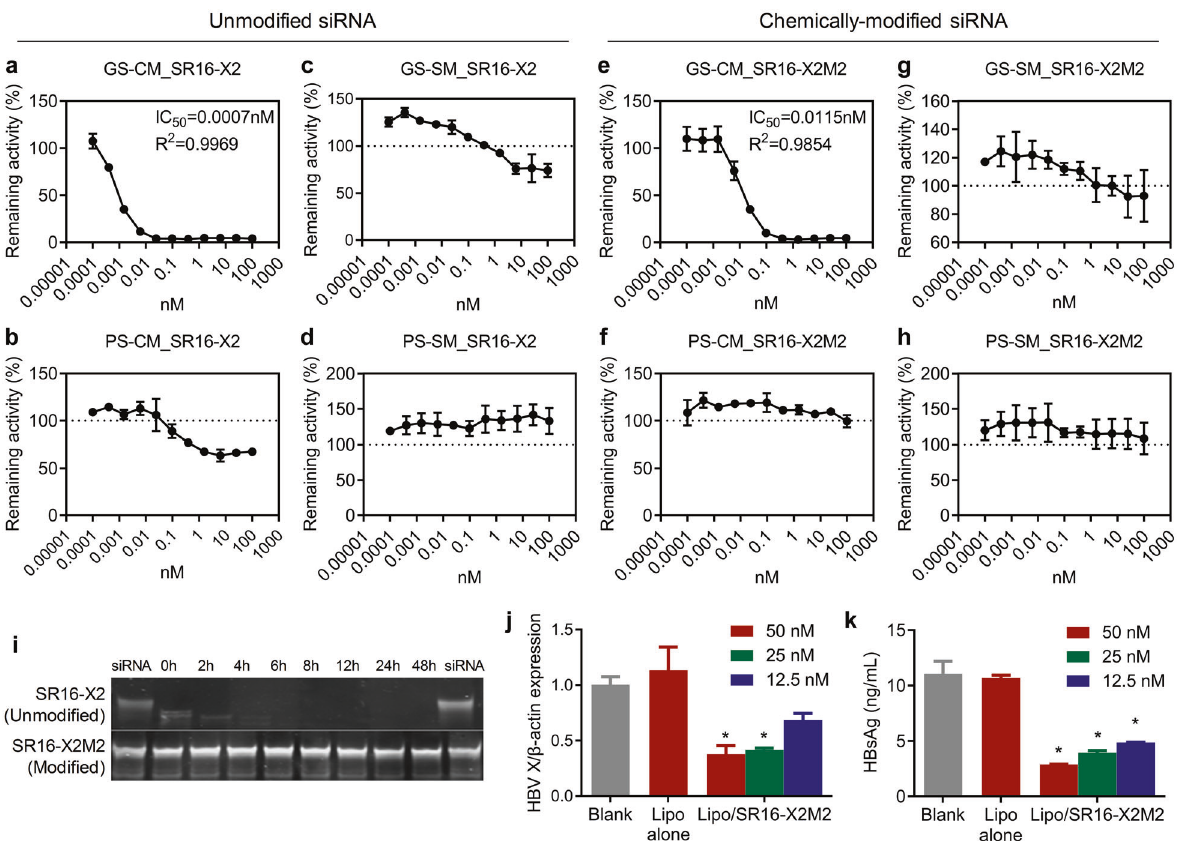
Fig. 3 In vitro performances of anti-HBV siRNAs. a – h On target and off-target activities of the unmodi fi ed ( a – d ) and chemically modi fi ed ( e – h ) anti-HBV siRNAs. psiCHECK ™ dual-luciferase reporter system, an extremely sensitive activity evaluation system, was employed in this assay. The transfection concentrations were 100, 25, 6.25, 1.5625, 0.3906, 0.0977, 0.0244, 0.0061, 0.0015, 0.0004, 0.0001 nM, respectively. GS-CM or PS-CM mean the guide strand (GS) or passenger strand (PS) of the siRNA match with its targeting mRNA incomplete match (CM) manner. The guide strand is the desired gene silencing modulator, revealing siRNA ’ s on-target activity. GS-SM or PS-SM means the guide or passenger strand of siRNA works via seed-region-matching, a miRNA-like pathway. Hence, gene silencing mediated by PS-CM, GS-SM, or PS-SM represents siRNA ’ s off-target effect. i Serum stability of unmodi fi ed SR16-X2 and modi fi ed SR16-X2M2 (siHBV). j , k In vitro anti-HBV activity of SR16-X2M2. Virus RNA expression ( j ) and HBsAg level in culture medium ( k ) of HepG2.2.15 receiving lipo-transfection of SR16-X2M2 at 50, 25, and 12.5 nM,